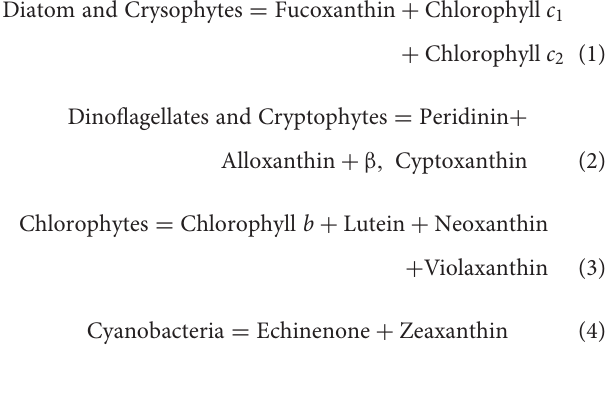
with a binocular (Zeiss R (cid:13) , Germany). At the beginning of